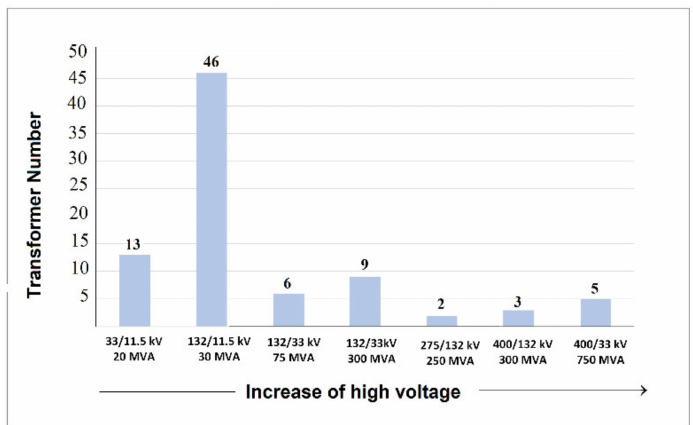
Figure 4. Classification of the 84 transformers according to the voltage (HV/LV, kV) and operated power rating, MVA. The voltage is related to the winding where HV = High Voltage in the secondary winding and LV = Low Voltage in the primary winding. The power rating, MVA = Mega volt-amperes where 1 mega volt-ampere = 1 million volt-amperes [45]. As seen in the figure, the transformers are classified according to the voltage, where the lowest transformer primary voltage is 33/11.5 kV (20 MVA), the medium transformer primary voltage is 132/11.5 kV (30 MVA), and the biggest transformer primary voltage is 400/33 kV (750 MVA).